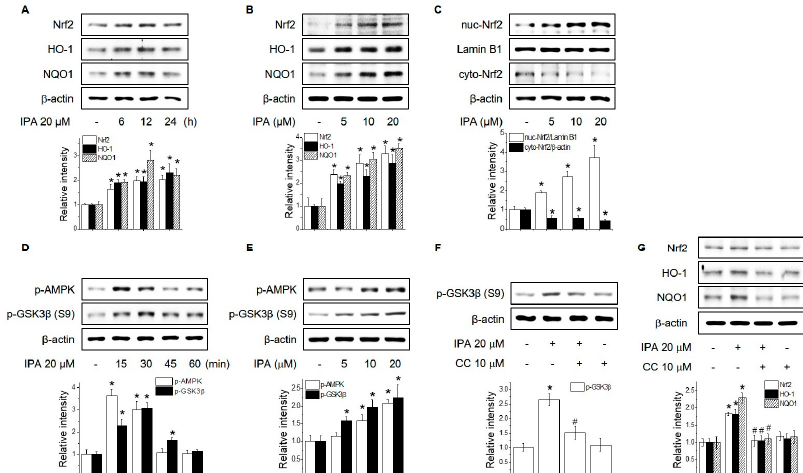
Figure 3. Effect of IPA on Nrf2 expression via the AMPK/GSK3 β signaling pathway. RAW264.7 cells were treated with 20 μ M IPA for 6–24 h ( A ) or 5–20 μ M IPA for 12 h ( B ). The protein levels of Nrf2, HO-1, and NQO1 were determined by Western blotting. ( C ) Effect of IPA on Nrf2 translocation. Nuclear and cytosolic proteins of RAW264.7 cells were analyzed by Western blotting. RAW264.7 cells were treated with 20 μ M IPA for 15–60 min ( D ) or 5–20 μ M IPA for 30 min ( E ). The AMPK and GSK3 β phosphorylation levels were determined by Western blotting. ( F ) RAW264.7 cells were pretreated with 10 μ M compound C for 1 h, followed by 20 μ M IPA for 30 min, and the GSK3 β phosphorylation levels was determined by Western blotting. ( G ) RAW264.7 cells were cultured with 10 μ M compound C for 1 h before the addition of 20 μ M IPA for 12 h. * Significantly different from the control at p < 0.01. # Significantly different from the IPA treatment group at p < 0.01.